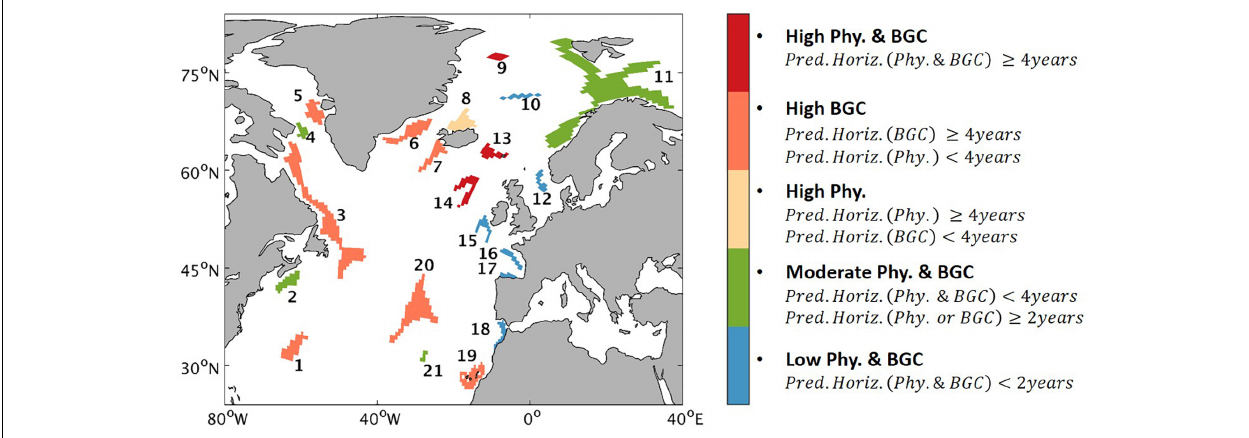
FIGURE 10 | Map of the sponge habitats showing the five categories of predictability. (1) High predictability in both physical (Phy.) and biogeochemical (BGC) fields (referred to “High Phy.&BGC”) – the predictability horizon is longer than (including) 4 years for at least one variable in each of the two fields (physical and biogeochemical). (2) High predictability only in biogeochemical fields (referred to “High BGC”) – the predictability horizon is longer than (including) 4 years for at least one variable in the biogeochemical fields but no such long predictability in the physical fields. (3) High predictability only in physical fields (referred to “High Phy.”) – the predictability horizon is longer than (including) 4 years for at least one variable in the physical fields but no such long predictability in the biogeochemical fields. (4) Moderate predictability in physical and biogeochemical fields (referred to “Moderate Phy.&BGC”) – predictability horizon in both two fields is less than 4 years, there are at least one variable in the two fields having predictability of longer than 2 years. (5) Low predictability in both physical and biogeochemical fields (referred to “Low Phy.&BGC”) – no variable has predictability of longer than 2